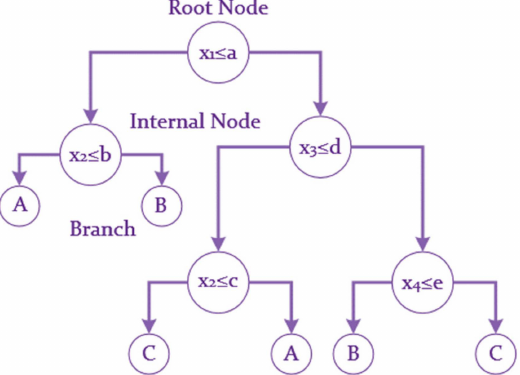
Figure 3. Decision tree structure consisting of three classes with four-dimensional property space.